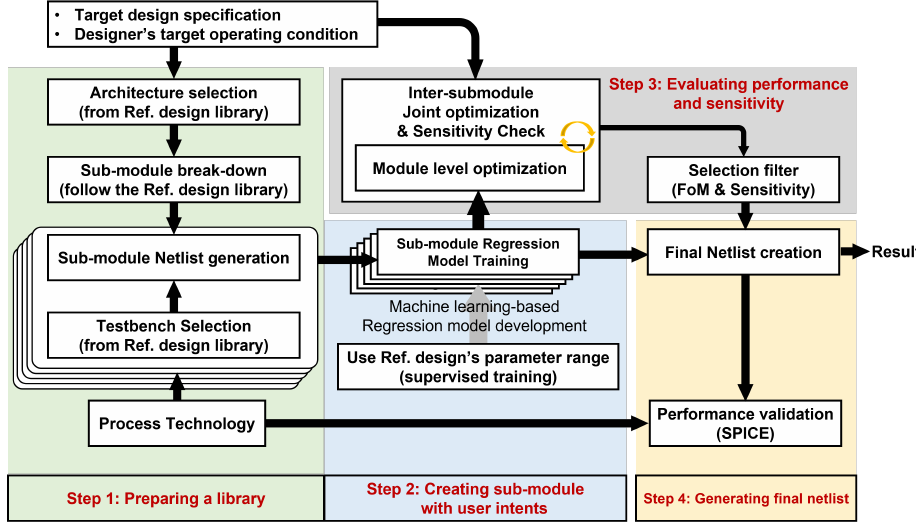
Figure 1. Top-level system diagram of the proposed AMS circuit optimization